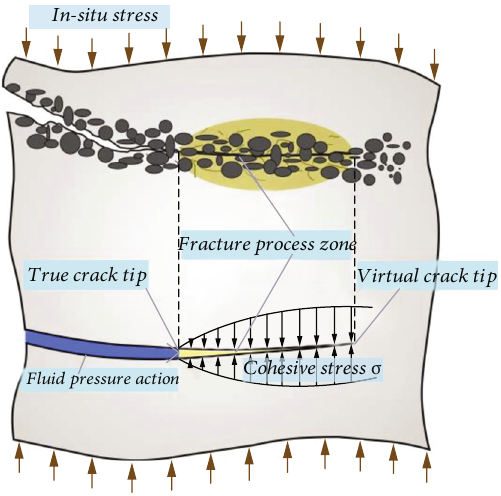
Figure 1: Schematic of